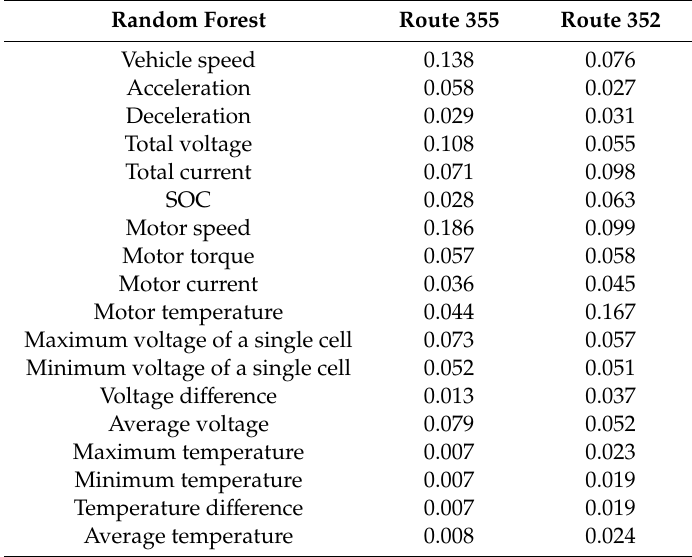
Table 11. Feature weights of each model in the case